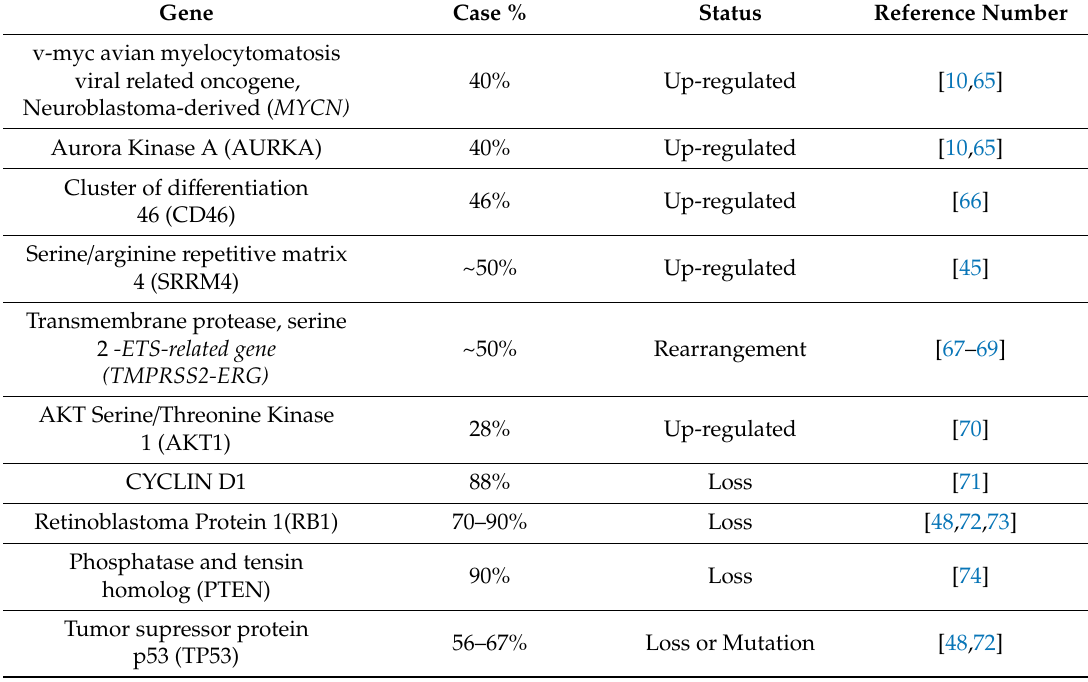
Table 1. Alteration in gene expression (approximate %) in therapy-induced neuroendocrine prostate cancer